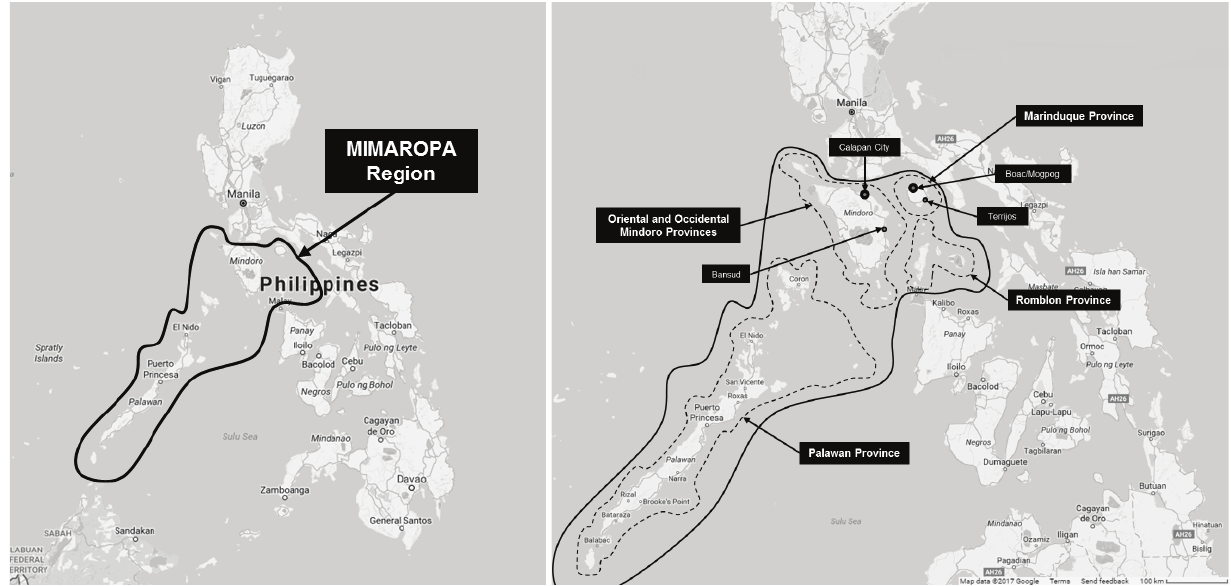
Figure 1. Map of the Philippines, MIMAROPA and its provinces within the Philippine Islands. cial confluence can be reflected by lower trip